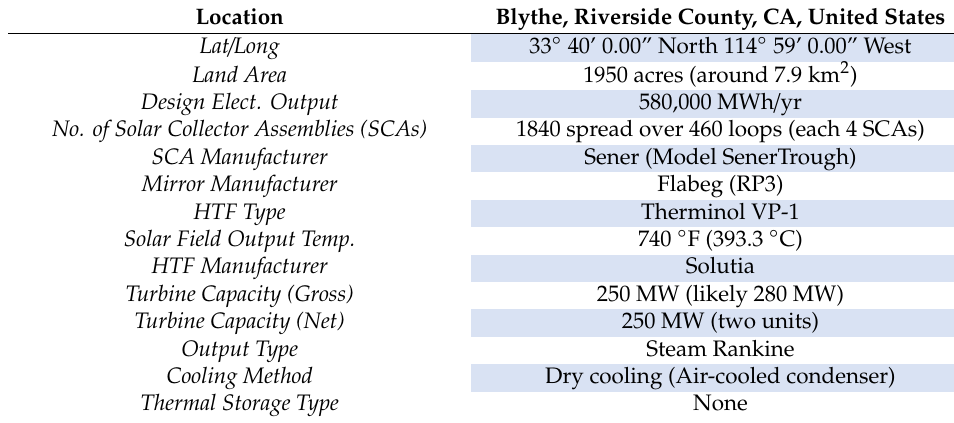
Figure 2. Google Earth view of Genesis solar energy project. Map data ©2020 Google. Table 1. Genesis Project specifications